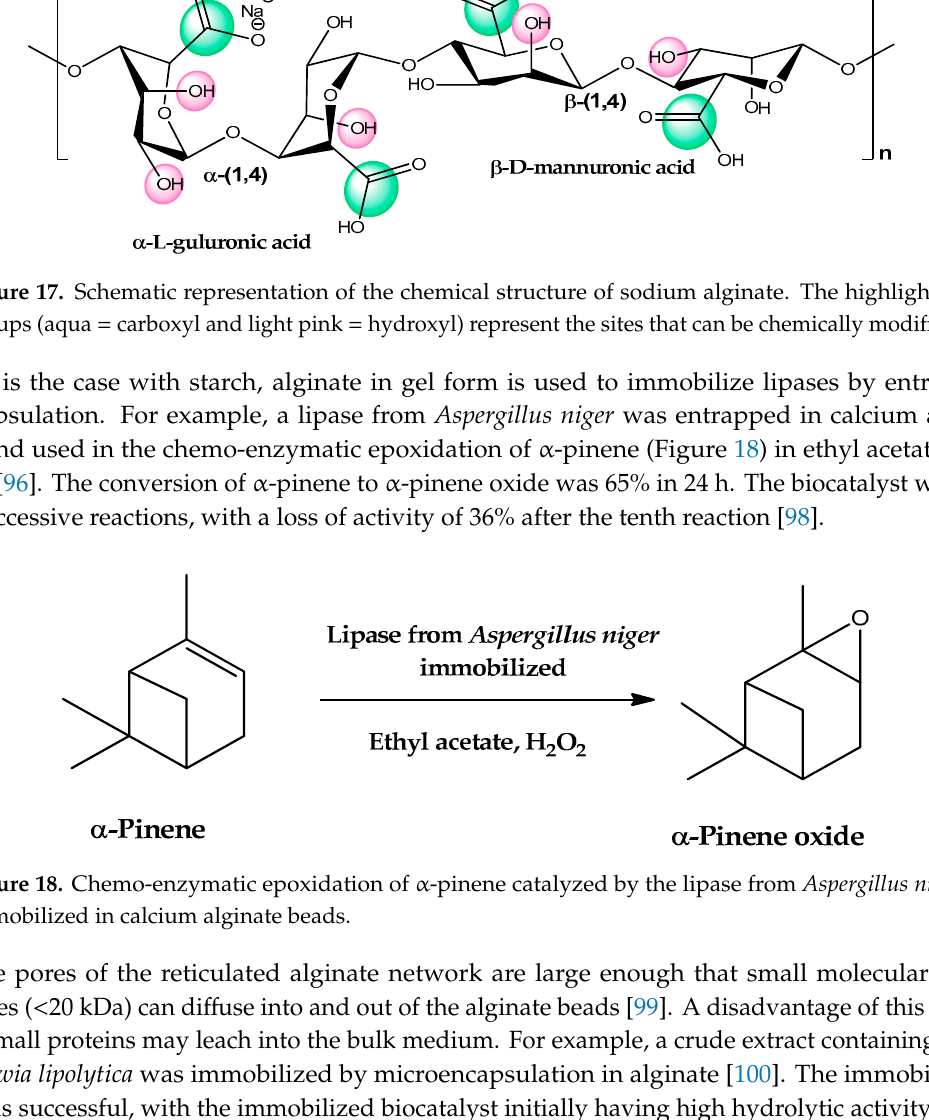
Figure 17. Schematic representation of the chemical structure of sodium alginate. The highlighted groups (aqua = carboxyl and light pink = hydroxyl) represent the sites that can be chemically modified.